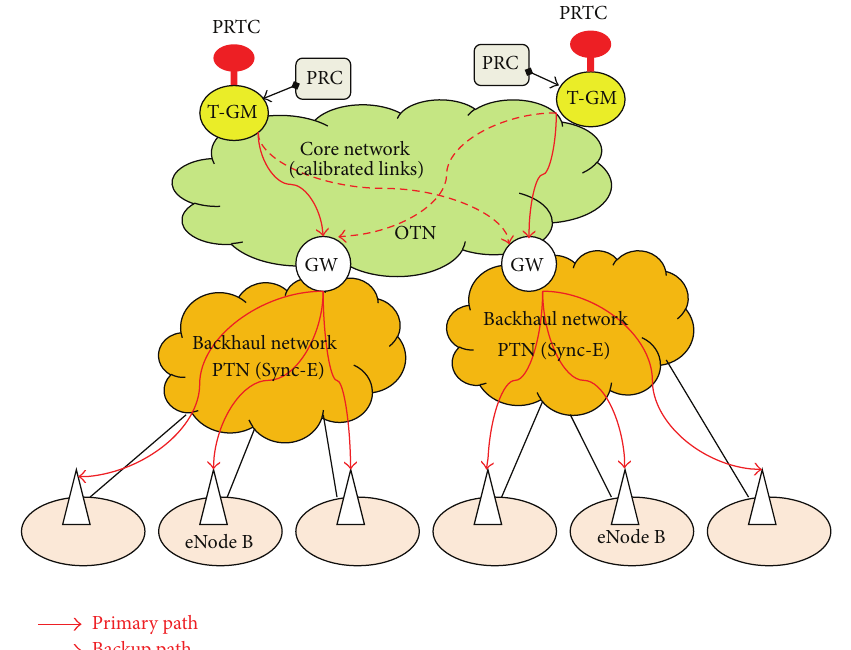
Figure 1: Architecture with centralized PRTC functions colocated with PRC. T-GM: telecom-grand master; GW: gate way.